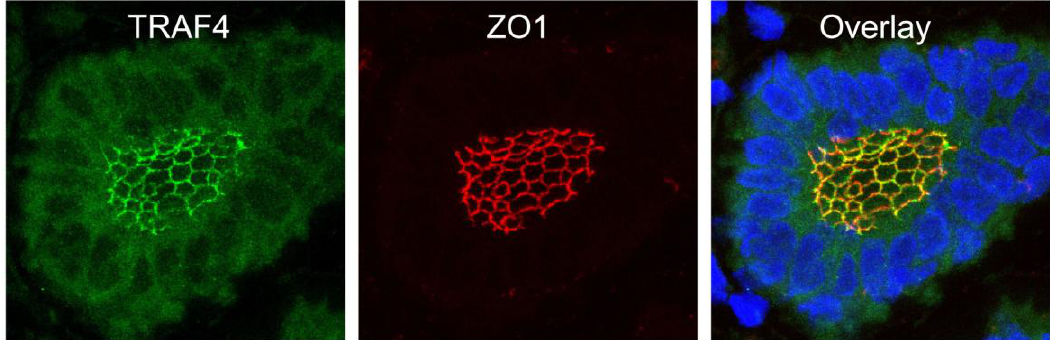
Figure 3. TRAF4 is localized at tight junctions (TJs) of normal human mammary epithelial cells. TRAF4 (green) and ZO1 (red) were co-labeled on paraffin embedded sections of a normal human breast duct. Images are confocal section projections showing the typical honeycomb-like shape of tight junctions. Nuclei were stained using Hoechst-33258